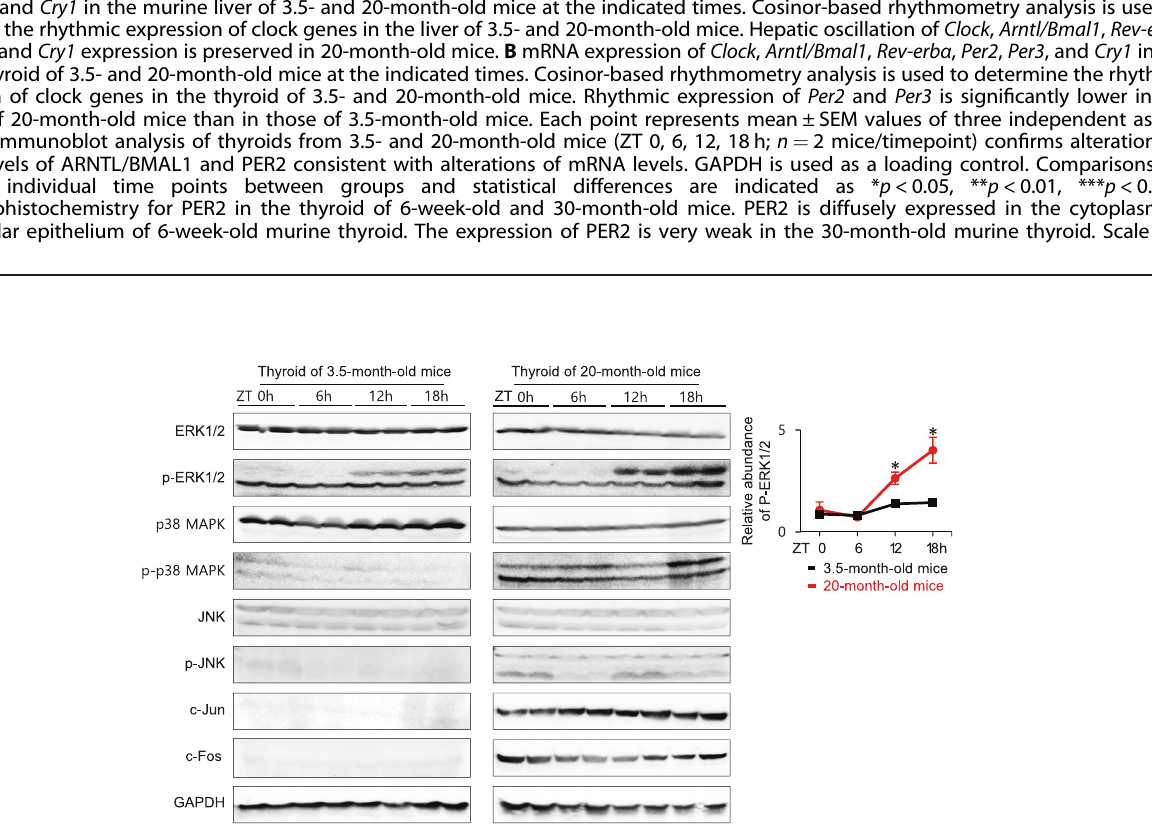
Fig. 4 Impaired circadian oscillation of Per promotes AP-1 activation in the aged murine thyroid. Immunoblot analysis of thyroid tissue from 3.5- and 20-month-old mice is used to measure protein levels for the MAPK and PI3K/AKT signaling pathways by timepoint (ZT 0, 6, 12, 18 h). ERK1/2 phosphorylation is higher in the thyroids of 20-month-old mice than in those of 3.5-month-old mice. The graph shows the relative abundances of phospho-ERK1/2 normalized to those of total ERK1/2. The amplitudes of circadian oscillations of phospho-ERK1/2 in the thyroids of 20-month-old mice were larger than those in the thyroids of 3.5-month-old mice. * p < 0.05. Phosphorylation of JNK is higher in the thyroids of 20-month-old mice than in those of 3.5-month-old mice. c-Fos and c-Jun expression is higher in thyroids of 20-month-old mice than in those of 3.5-month-old mice. GAPDH is used as a loading